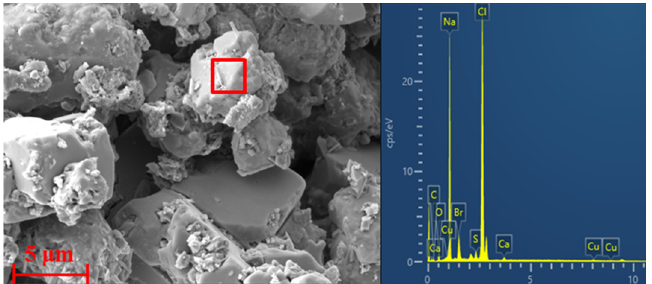
Figure 4. SEM micrographs and EDS analysis of the slagging samples collected from the wall of the quench tower.